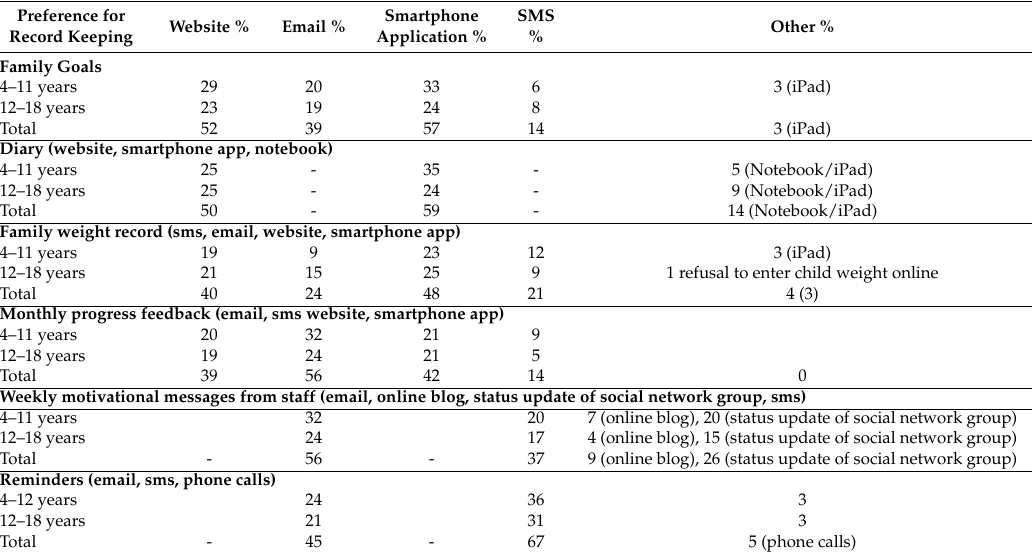
Table 2. Identified preferences of program content and contact by age group.